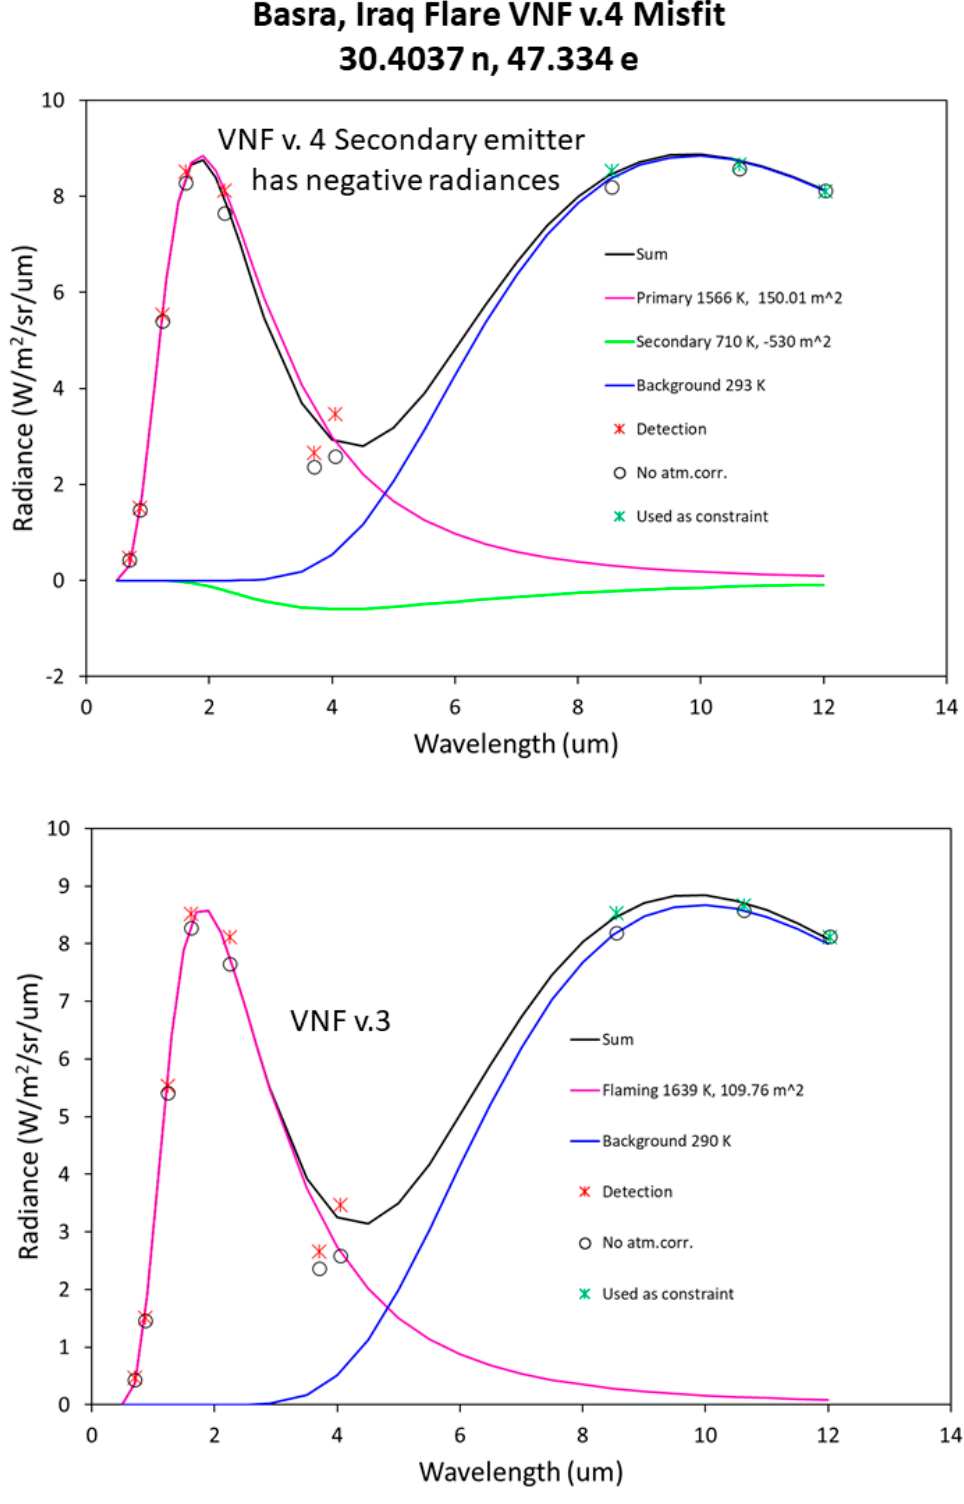
Figure 14. Spectral diagrams of a Type 4 misfit pixel from a Basra gas flare. The esf for the secondary emitter is negative, resulting in negative radiances. The pixel moves from Type 4 to Type 5 with the VNF v.3 fit.